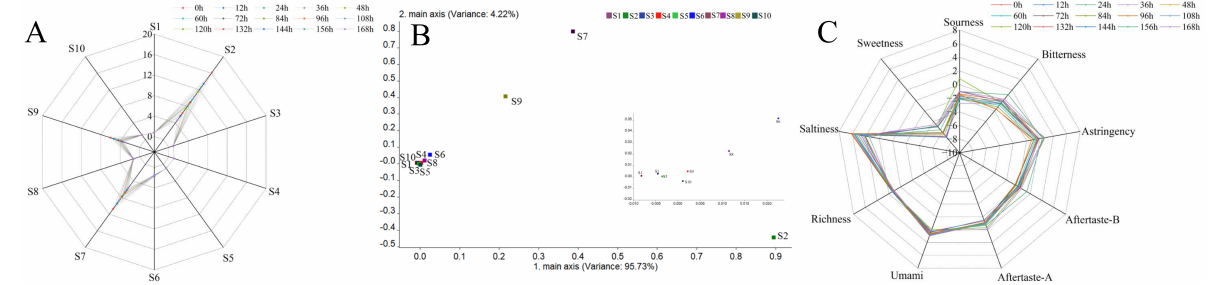
Figure 2. Radar chart ( A ) of response values and loadings analysis ( B ) of sensors in E-nose; radar chart of response values of taste sensors for freshly squeezed strawberry juice during cold storage ( C ).